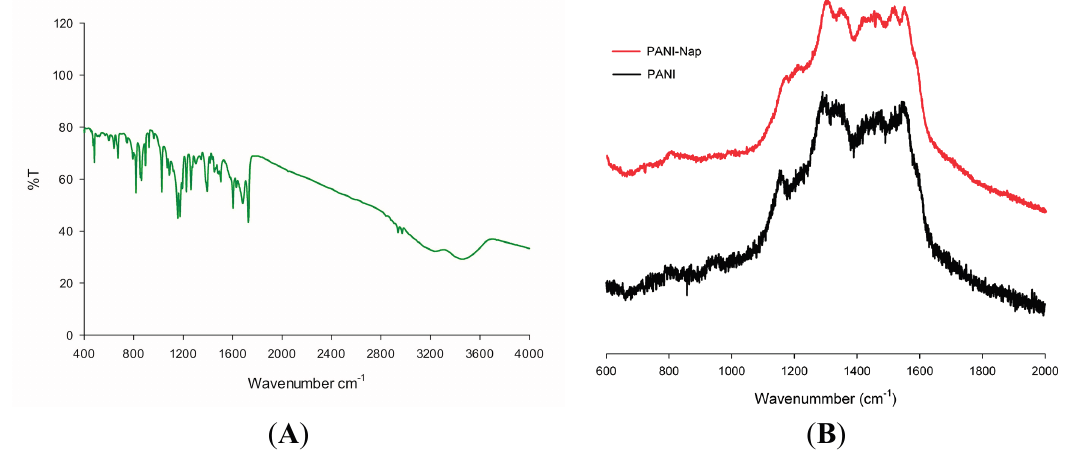
Figure 3. ( A ) FTIR spectra of PANI-Nap; ( B ) Raman spectra of PANI and PANI-Nap.